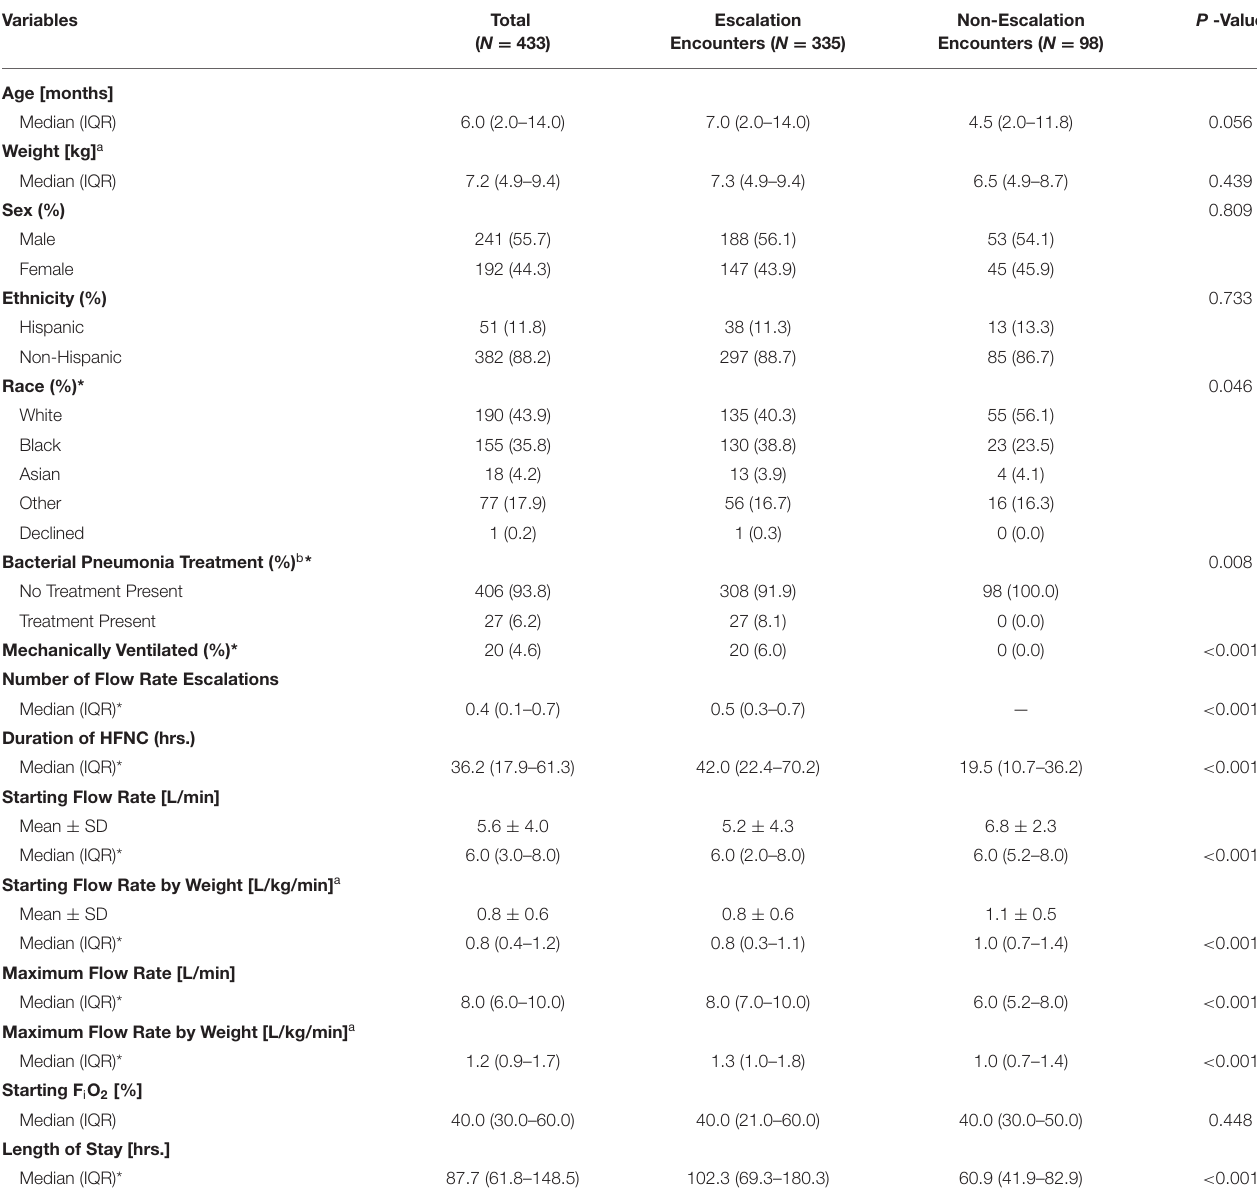
TABLE 1 | Descriptive characteristics for the study population, including demographics, anthropometrics, and comorbidities, stratified by the presence of one or more flow rate escalations.